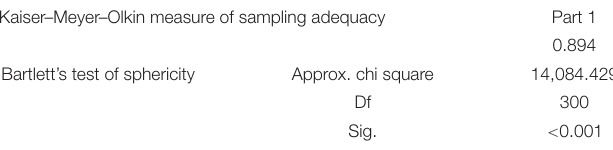
TABLE 7 | Sample validity.